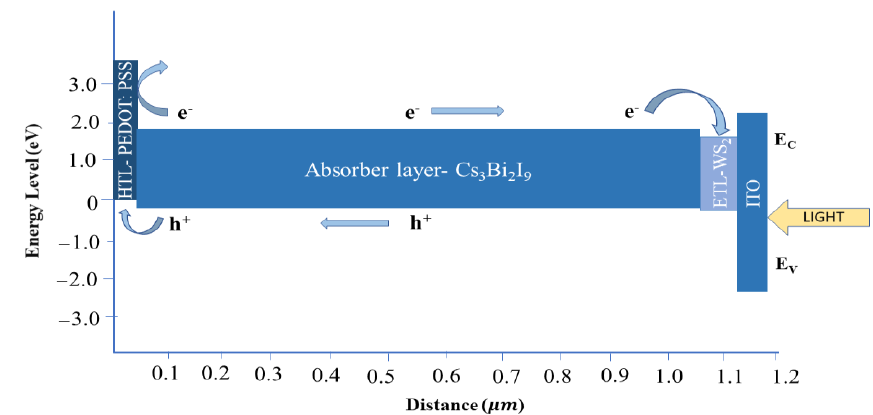
Figure 2. Energy band diagram of the selected configuration in this study.